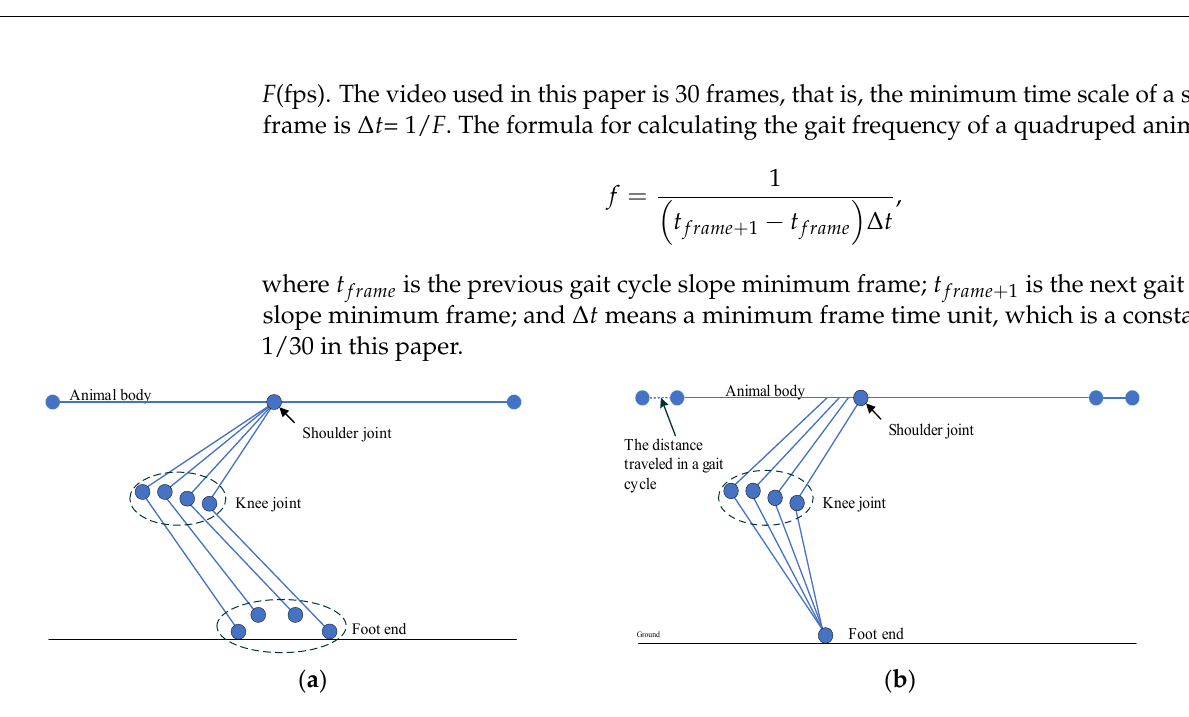
Figure 5. ( a ) The swing phase of a quadruped animal; ( b ) the support phase of a quadruped animal.